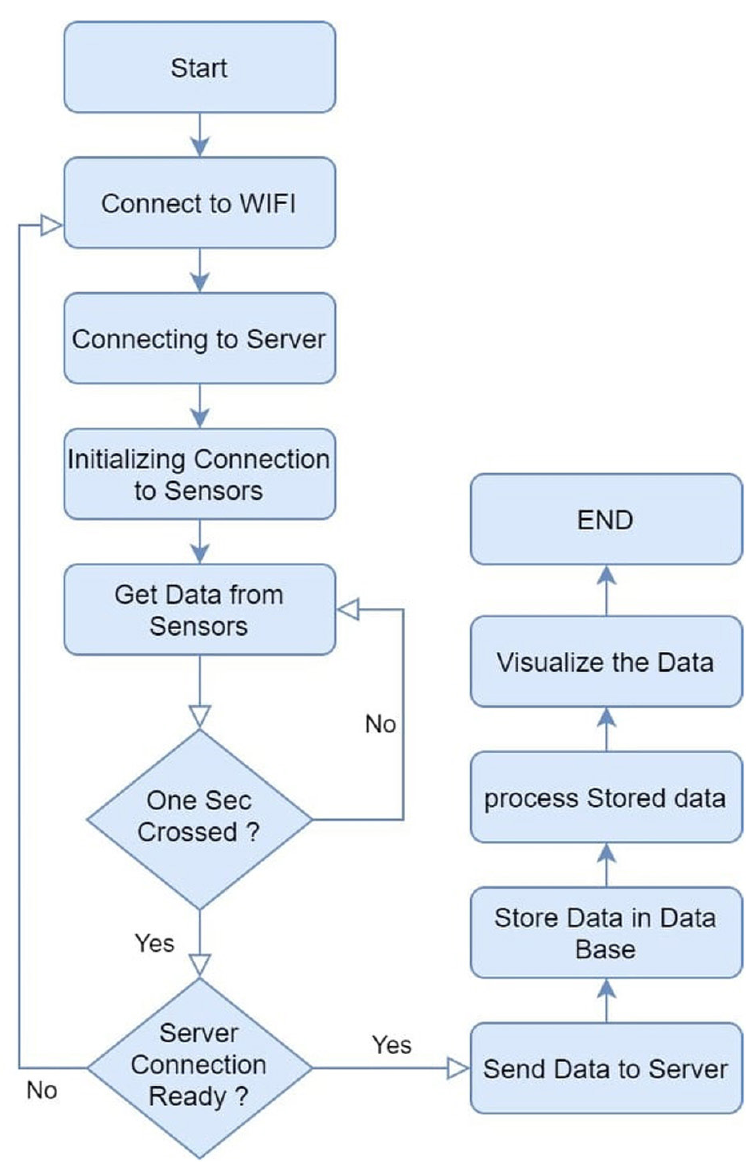
Fig. 5. It shows the flow chart of the proposed